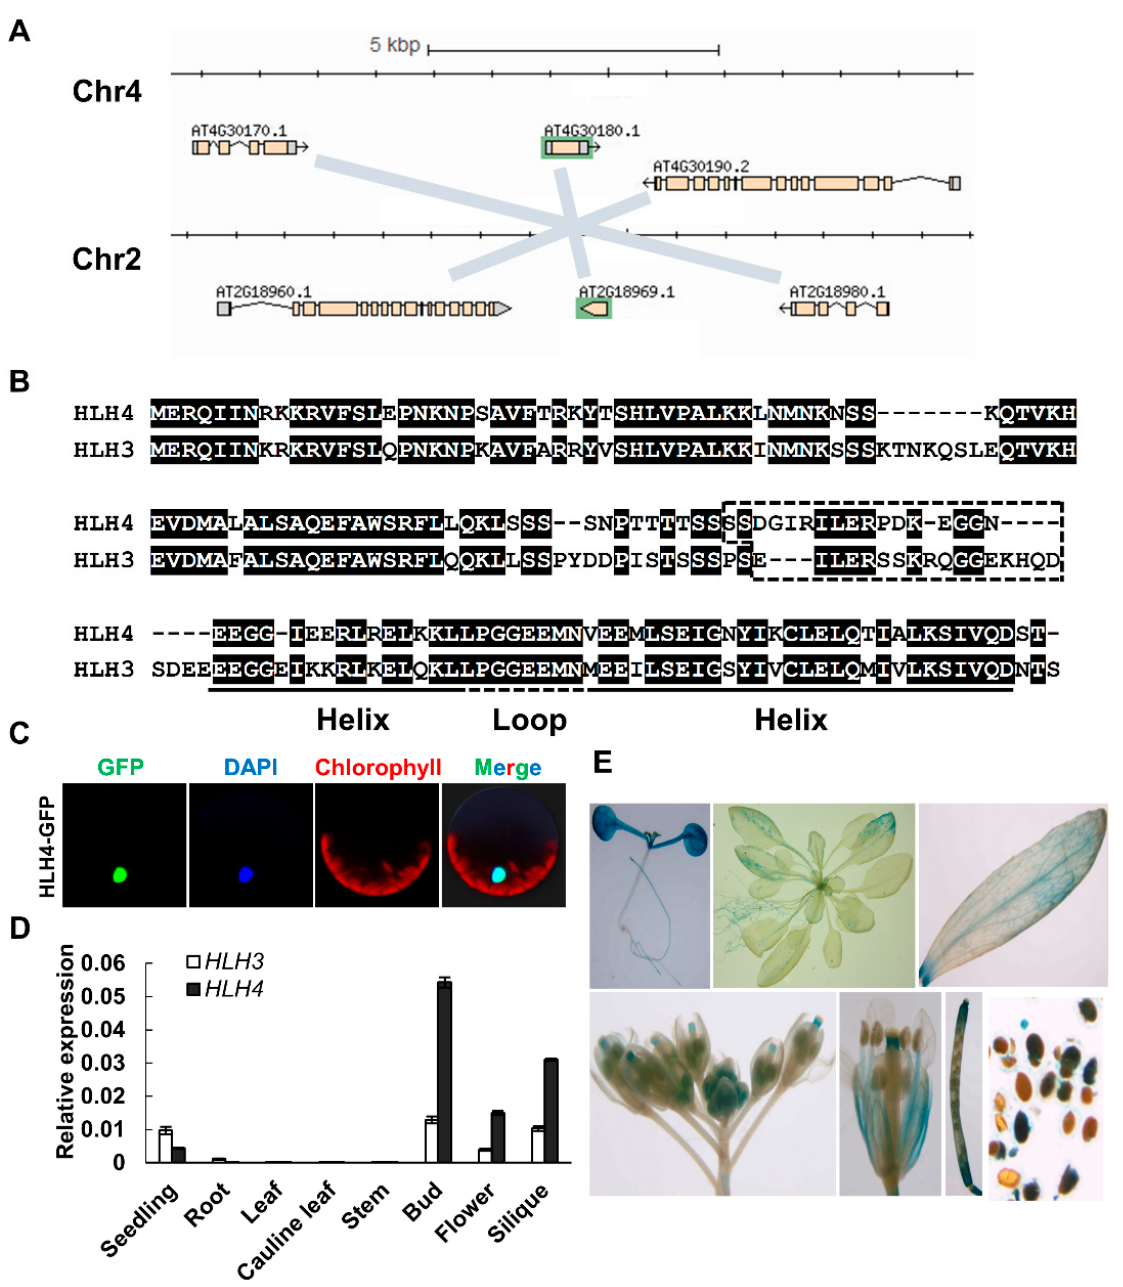
Figure 2. HLH4 is localized in the nucleus and is predominantly expressed in seedlings and reproductive organs. ( A ) Genome organization of HLH4 and synteny with its paralog HLH3 on A. thaliana chromosomes. ( B ) Protein sequence alignment of HLH4 and HLH3. Helix-loop-helix structure domains (https://www.predictprotein.org/, accessed on 21 March 2022) are indicated, and the dashed box represents hypothetical basic regions. ( C ) Subcellular localization of HLH4-GFP fusion protein in A. thaliana protoplasts. ( D ) RT-qPCR analysis of HLH4 expression from various tissues. Data represent mean ± SD of three biological replicates with three technical replications ( n = 9). ( E ) In vivo analysis of the HLH4 expression pattern using proHLH4::GUS reporter lines.